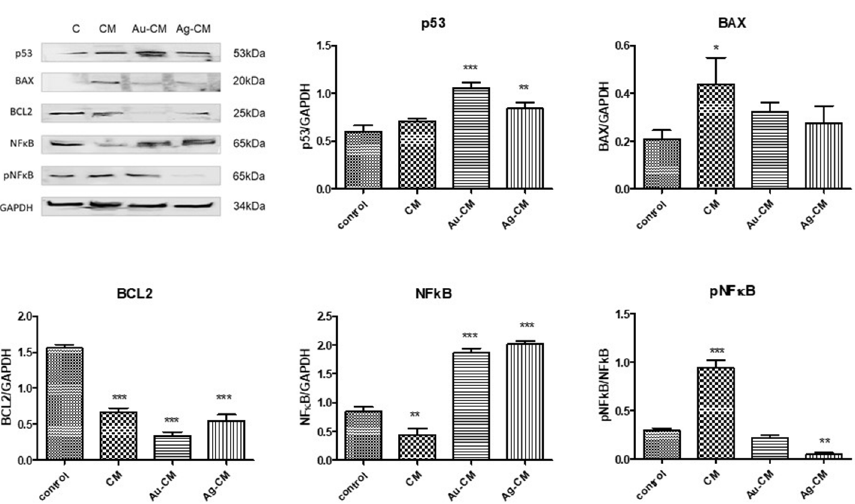
Figure 9. The protein expressions of p53, BAX, BCL2, NFkB and pNFkB in DLD-1 cells by Western blot examination. DLD-1 cells were treated with 40 µg/mL CM extract, 40 µg/mL Au-CM, and 4 µg/mL Ag-CM. In the upper panel are the images of the Western blot bands; in the lower panel are the results normalized to GAPDH. Statistical analysis was performed with one-way ANOVA and Bonferroni’s posttest (* p < 0.05, ** p < 0.01, *** p < 0.001 compared to control cells).